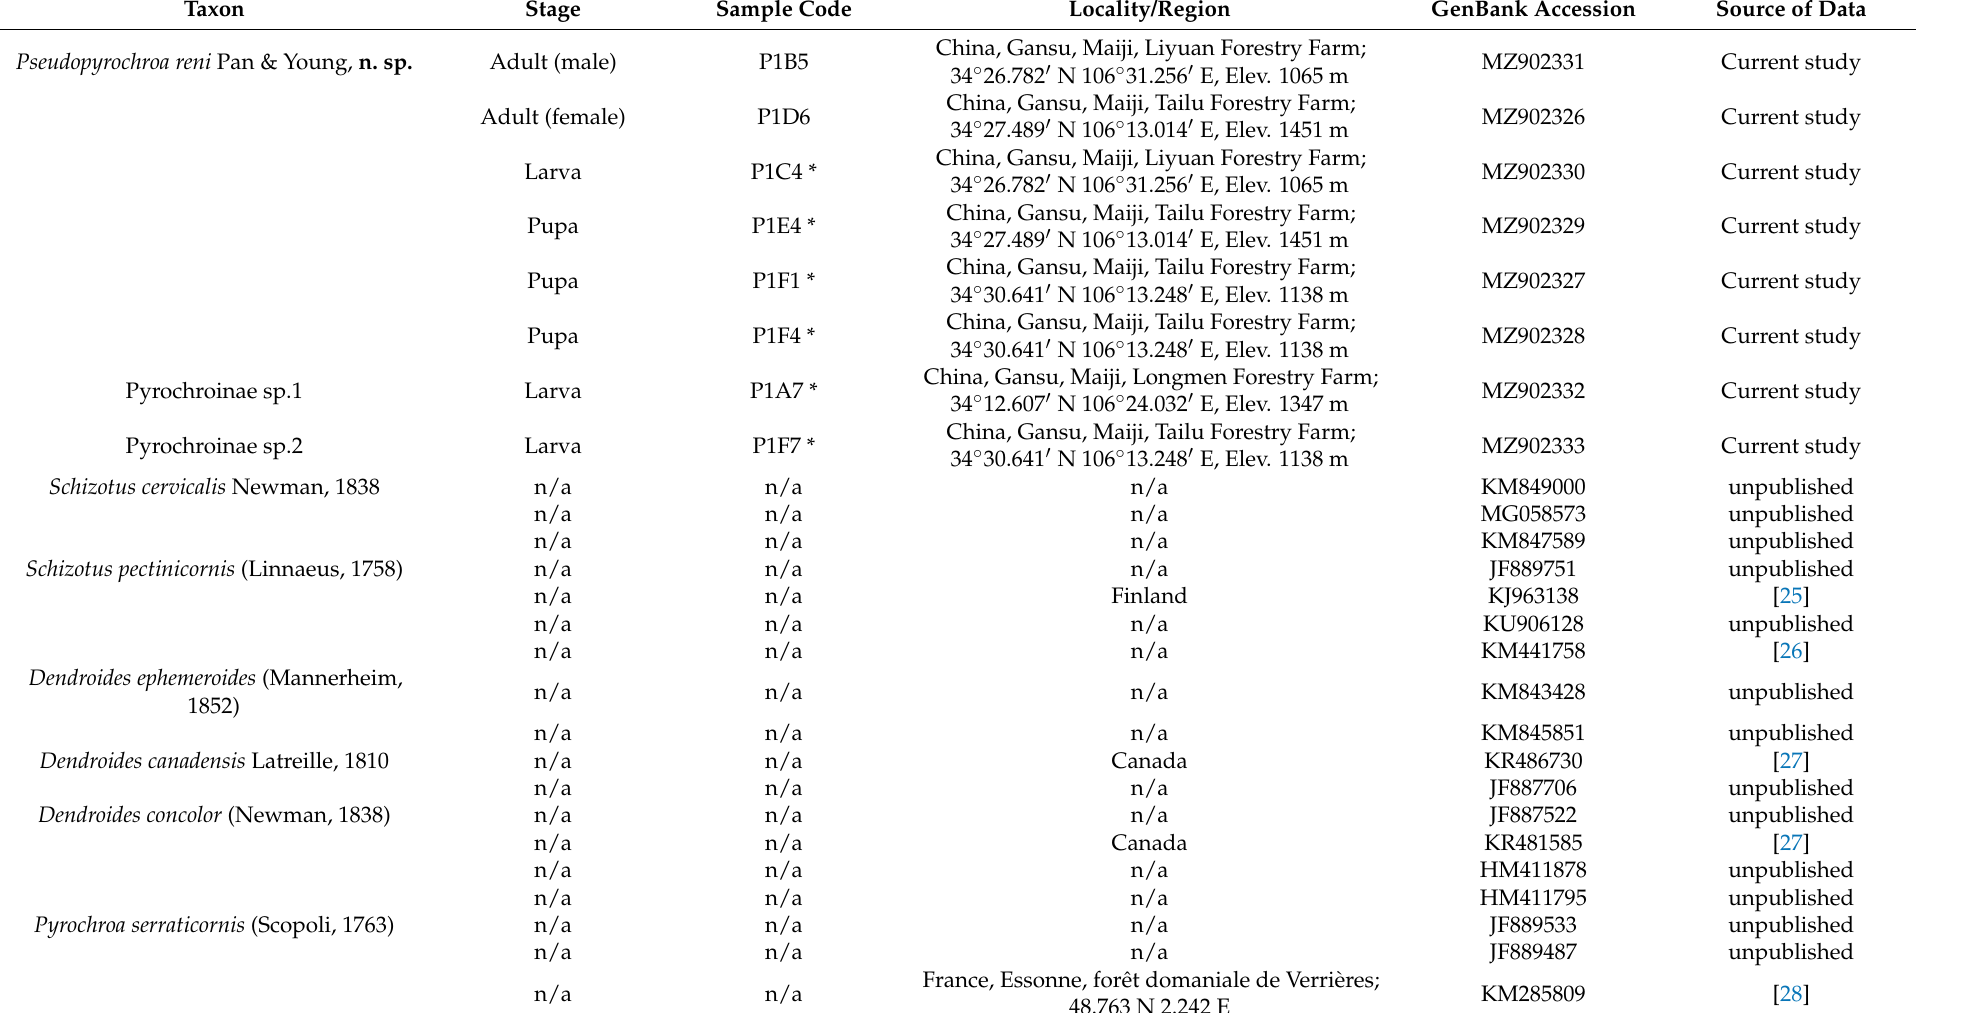
Table 1. Species, codes, and sampling locality for the molecular analyses based on COI